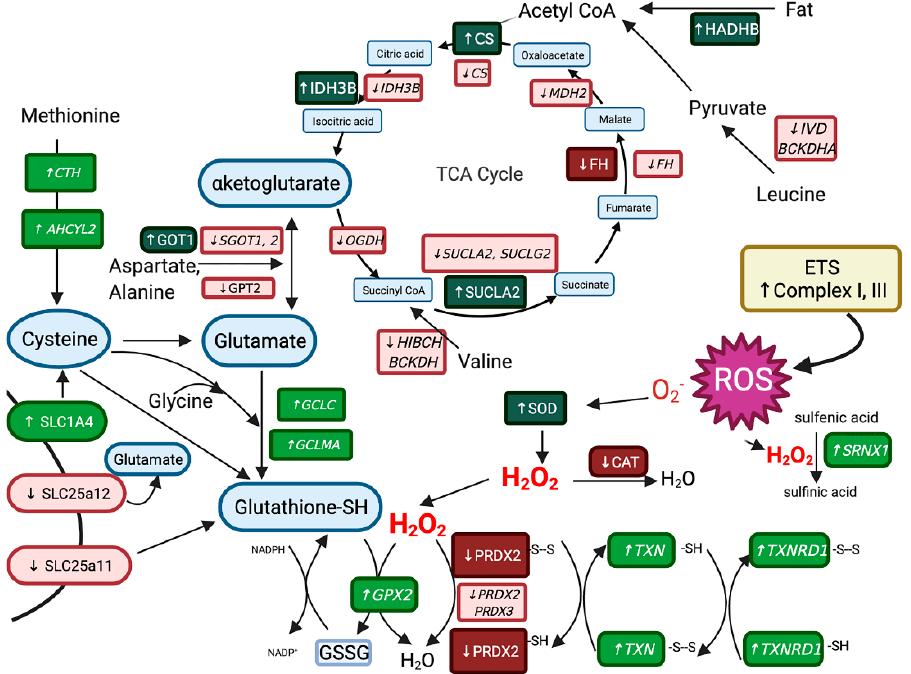
Figure 8. The differentially expressed proteins (dark green upregulated and dark red downregulated) and genes (light green italics upregulated, light red italics downregulated) involving antioxidants, the tricarboxylic acid cycle (TCA), cysteine synthesis, and glutathione synthesis in muscle from RER-susceptible compared to control horses. RER-susceptible horses had increased expression of complexes I and III in the electron transfer system which generated reactive oxygen species (ROS). RER-susceptible horses had increased expression of superoxide dismutase (SOD) which produces H 2 O 2 and decreased expression of antioxidant proteins catalase (CAT) and the cysteine-based antioxi- dant peroxiredoxin 2 (PRDX2) as well as increased expression of the cysteine-based genes sulfiredoxin ( SRXN1 7.98 log 2 FC), thioredoxin, and thioredoxin reductase, which all reduce H 2 O 2 to H 2 O. Genes involved in the transport and synthesis of cysteine from methionine and the transport and synthesis of the antioxidant glutathione from cysteine, glycine and glutamate were DEG in RER-susceptible ver- sus controls. Proteins (increased) and genes (decreased) in the TCA cycle that produce the glutamate precursor alpha ketoglutarate as well as NADH for the electron transport chain were differentially expressed in RER-susceptible compared to control horses. Abbreviations: AHCYL2 adenosyl